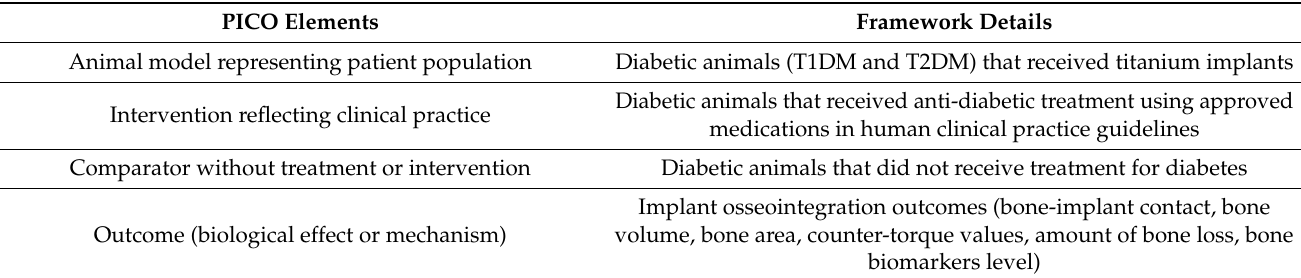
Table 4. PICO research framework. PICO Elements Framework Details Animal model representing patient population Intervention reflecting clinical